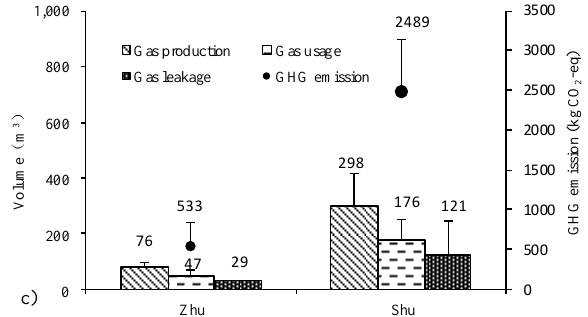
Figure 4. Gas usage by month ( a ) and leakage of household biogas by location ( b ) and by volume ( c ) in the two study villages during a 12-month period. Notes: CTT indicates connecter in tank top; the bars indirate Standard Deviation; 13 biogas household in Zhu and Shu were monitored.